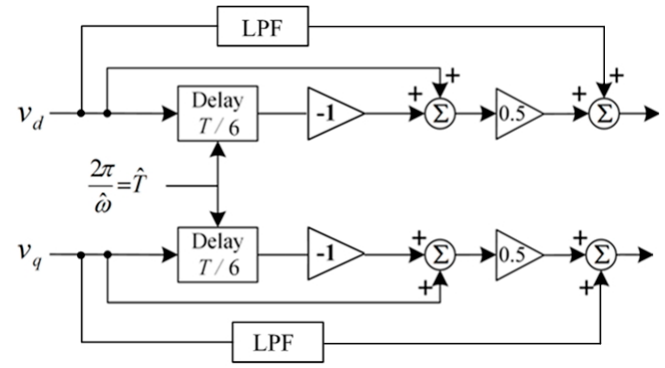
Figure 8. Time-domain implementation of the EDSC.